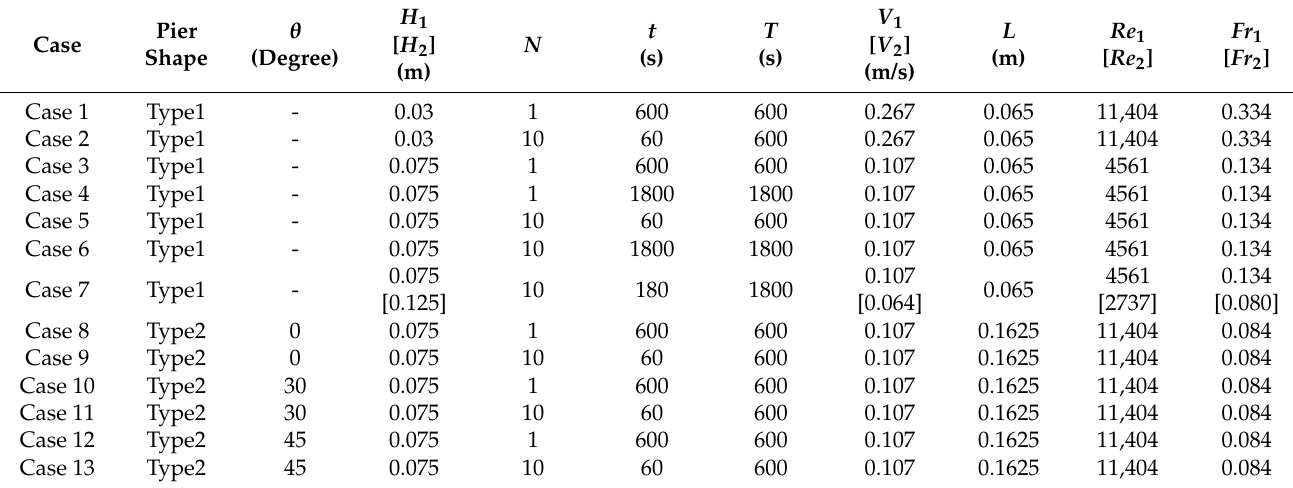
Table 1. List of experimental cases.